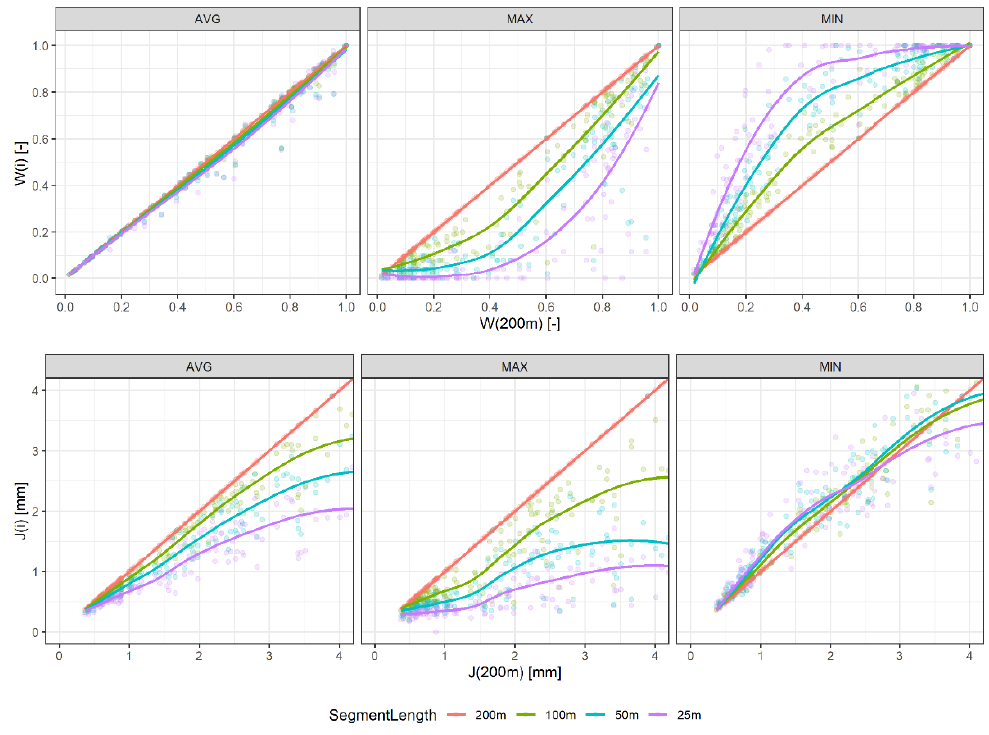
Figure 11. An influence of analytical segment length on the W and J index values.